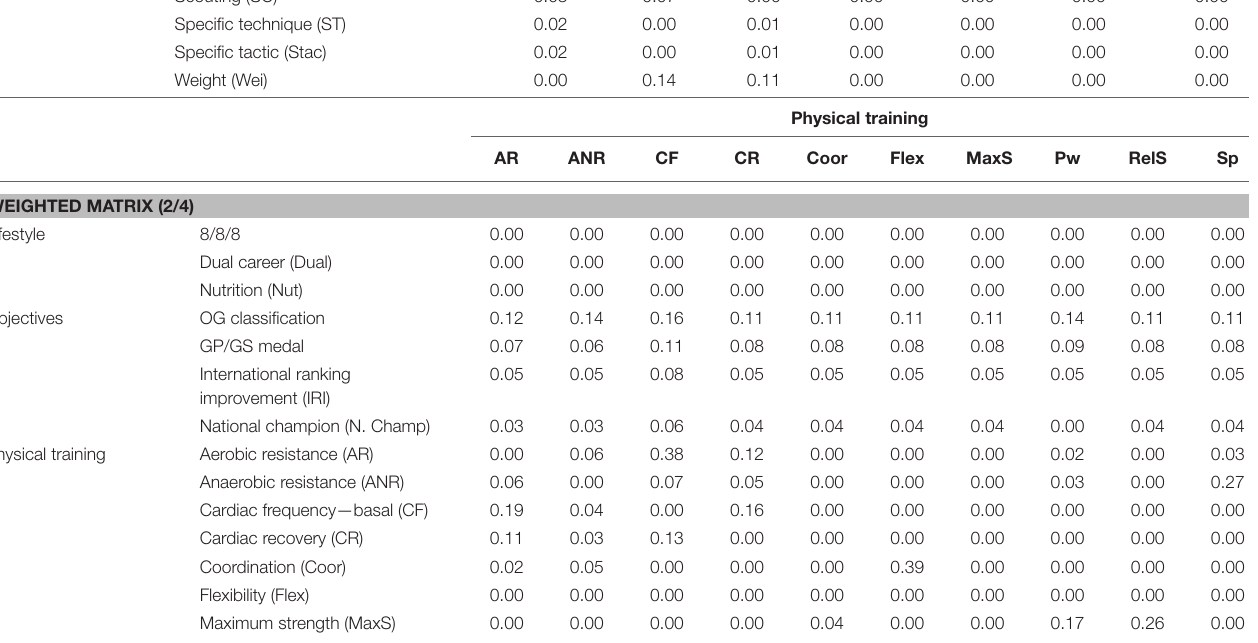
Lifestyle Objectives 8/8/8 Dual Nut OG